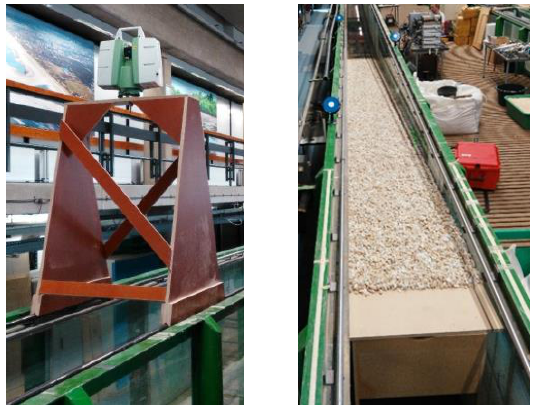
Figure 2. Left. Special wooden construction for mounting the laser scanner above the flume. Right. Scanner view of the scene.